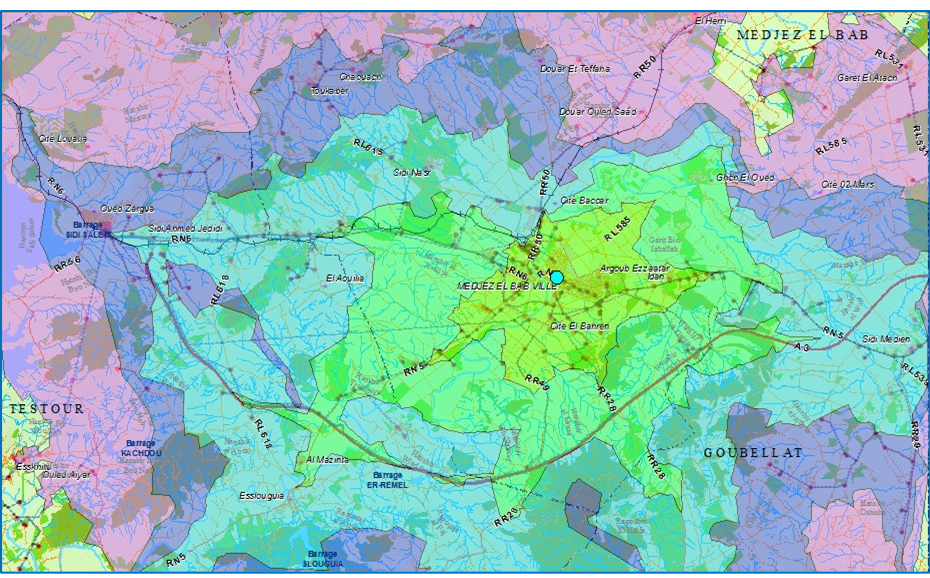
Figure 16. Polygons representing service areas of 5, 10, 15, 20, and 30 min from Medjez El Bab City.